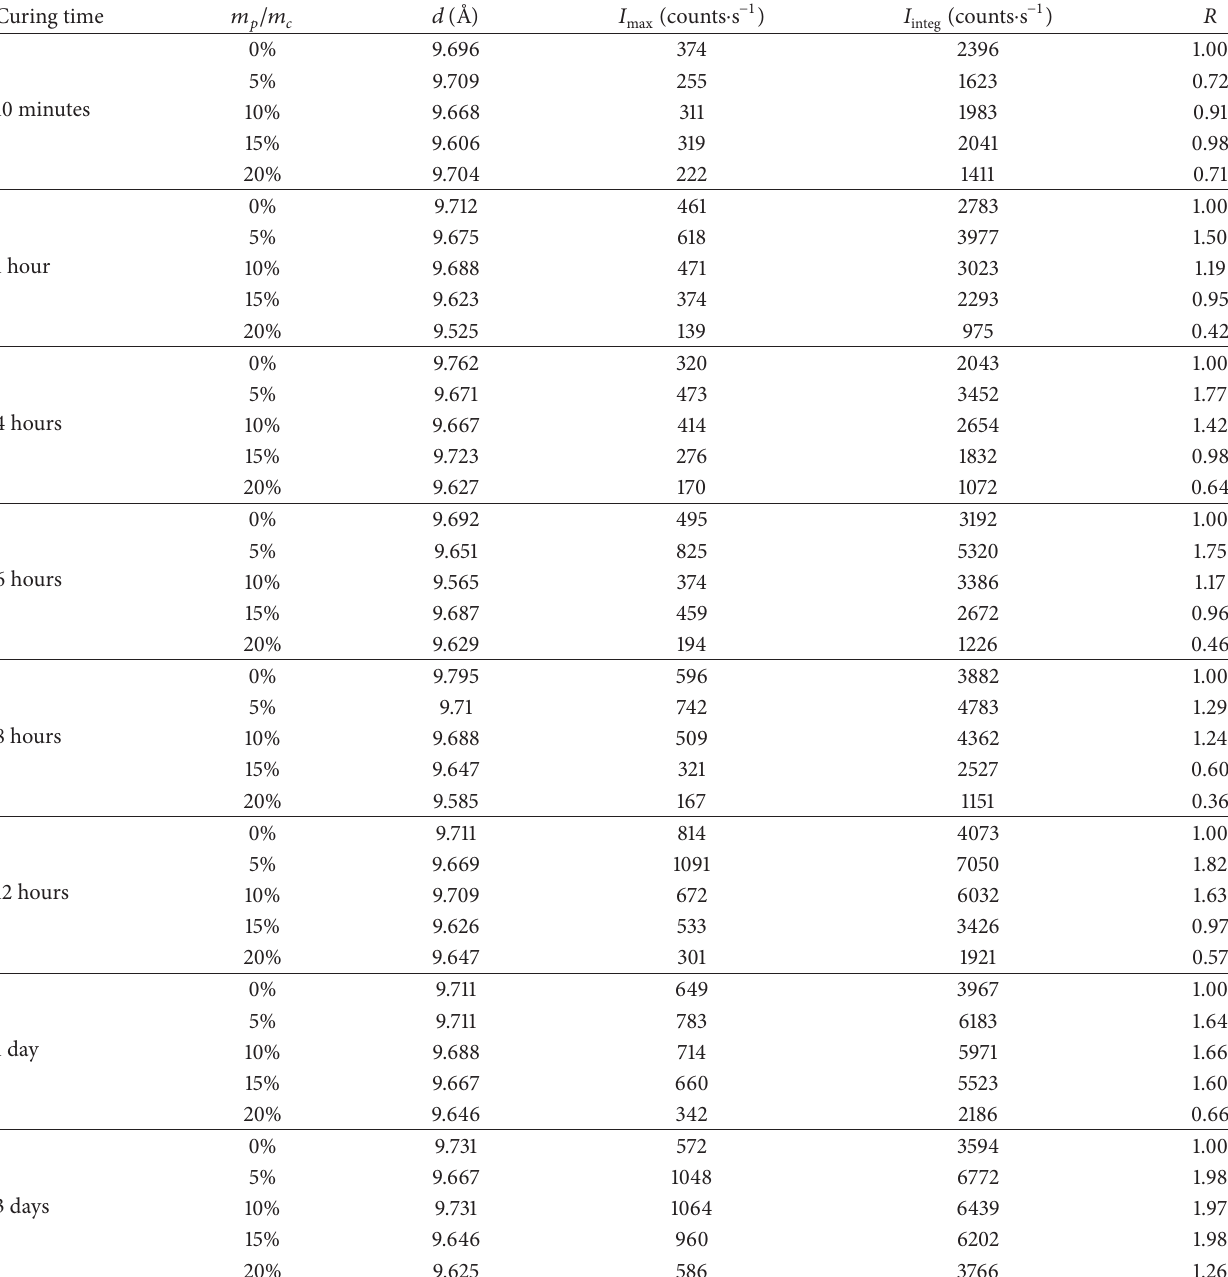
Table 5: The integrated results of XRD peak of AFt in the pastes with SAE